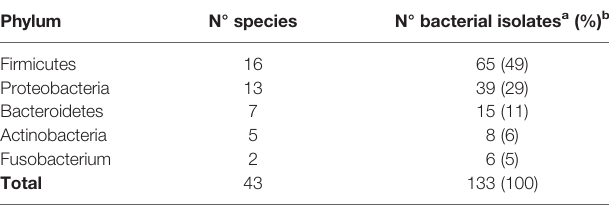
TABLE 2 | Taxonomic breakdown of isolates from the core of hypertrophied tonsils at phylum level. Phylum